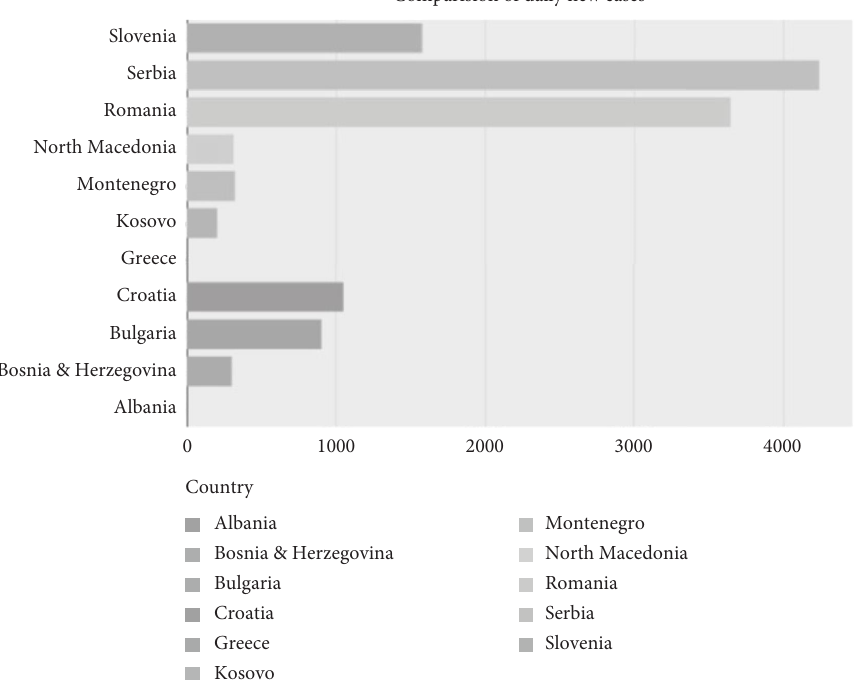
Figure 4: User-choice possibility to generate a bar chart on COVID-19 metrics of